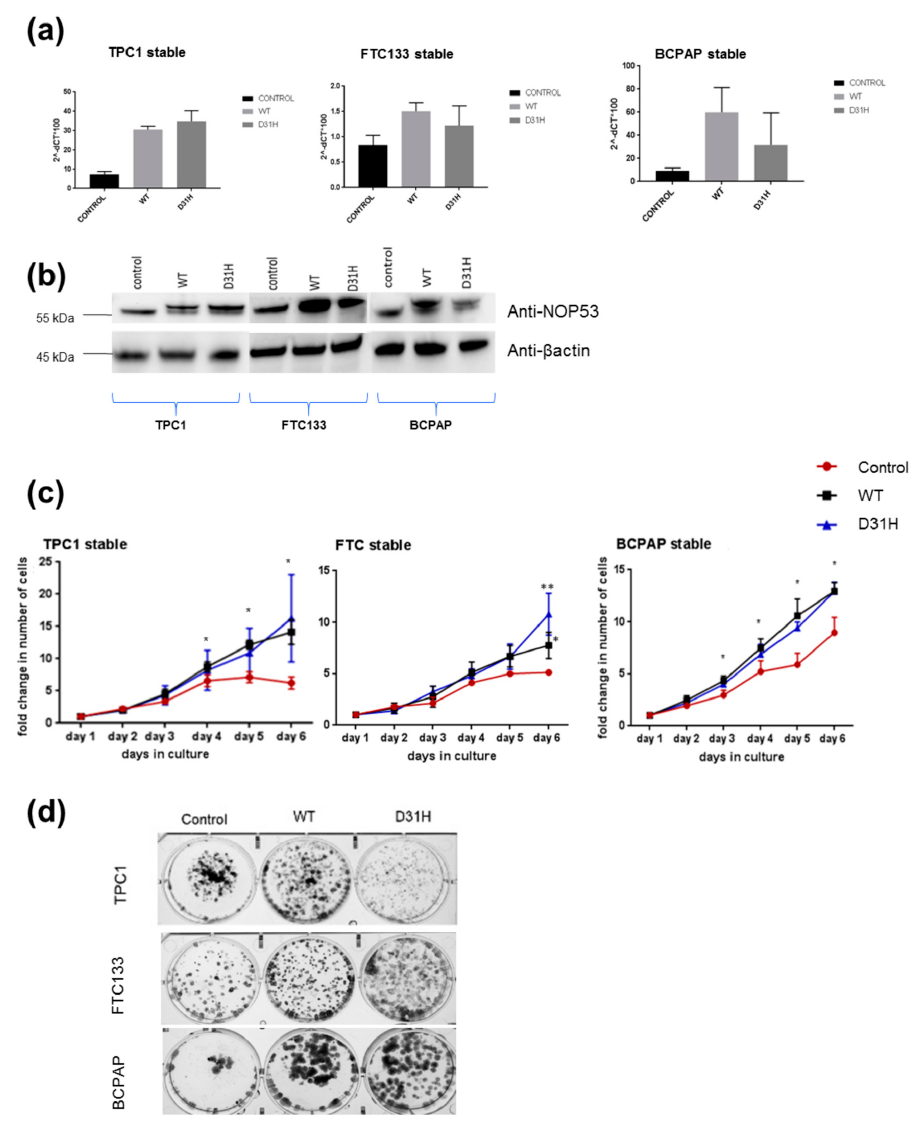
Figure 5. E ff ects of stable overexpression of NOP53 in three cell lines (TPC1, FTC133, BCPAP): ( a ) Validation of stable overexpression of wild type (WT) and D31H mutant NOP53 in three cell lines by qPCR; ( b ) Validation by Western blot. The lower band corresponds to the endogenous protein expression, whereas the upper band represents the exogenous overexpressed protein. The total protein lysates used were 25 µ g for TPC1 cell line, and 30 µ g for FTC133 and BCPAP cell lines. GAPDH and β -actin were used as an internal and loading control for qPCR and Western blot, respectively; ( c ) Overexpression of WT and D31H mutant NOP53 significantly increased the cell proliferation in thyroid cancer cell lines compared to the vector control; ( d ) Overexpression of WT and D31H mutant NOP53 significantly increased the cell clonogenicity in thyroid cancer cell lines compared to the vector control. * indicates adjusted p value < 0.05 compared to control. ** indicate adjusted p value < 0.01 compared to control. Error bars indicate standard